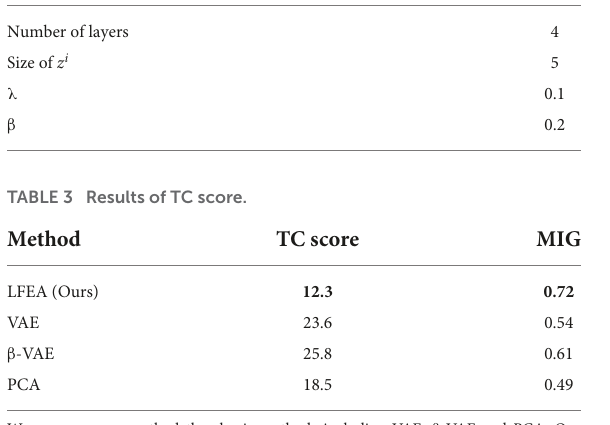
TABLE 2 Detail parameters for LFEA.